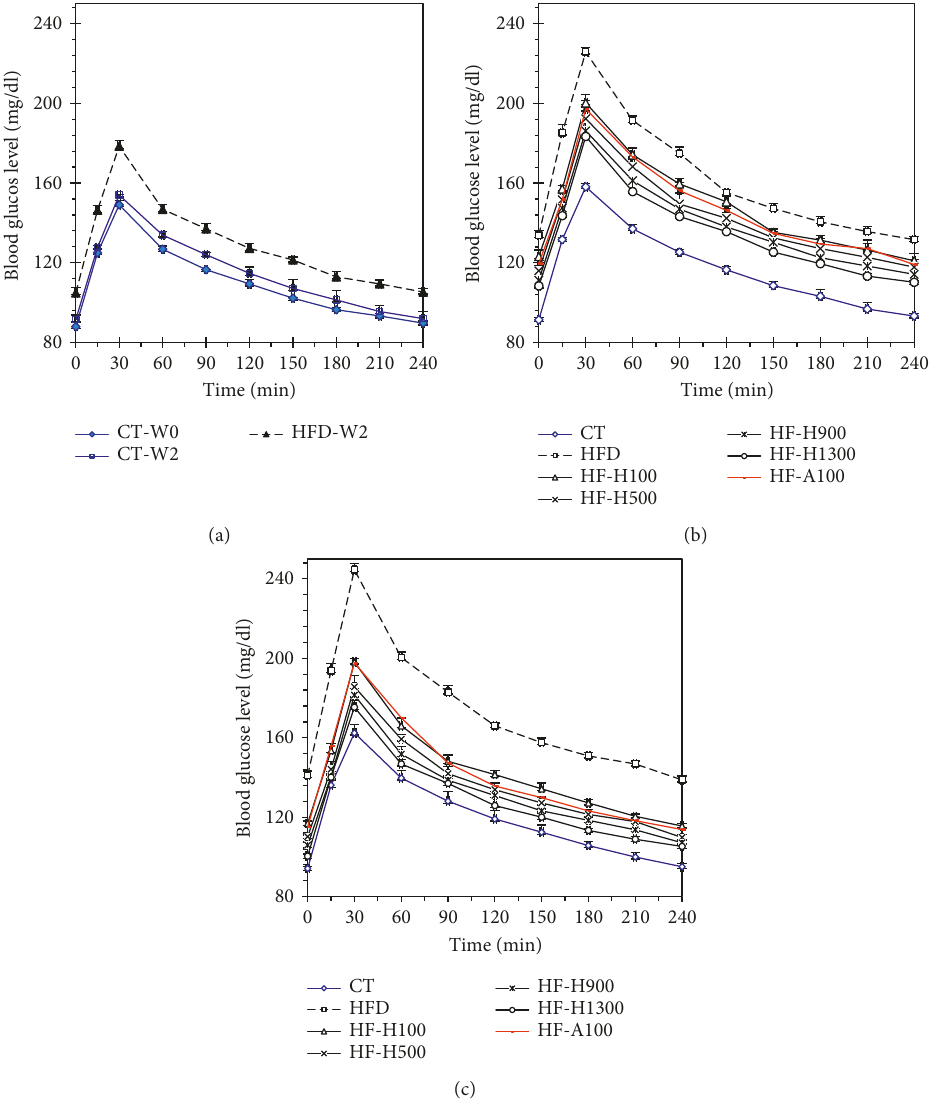
Figure 3: Postprandial blood glucose level (PBL) in mice at the end of (a) week 0 (W0) and week 2 (W2); (b) week 4; and (c) week 6 of experiments (data were shown in mean ± standard deviation, n �